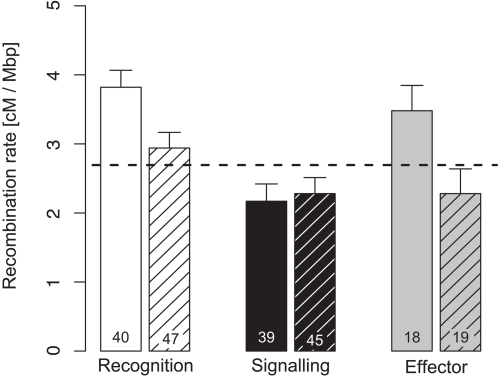
Average local recombination rates (± S.E.) of immune genes in the D. melanogaster genome.Immune genes were grouped according to their function during the immune response and whether they were contained in a cluster (open columns) or not (hashed columns). The dashed horizontal line gives the average genomic background recombination rate. The numbers inside each bar represent the number of immune genes found in the respective group. Details on statistical differences can be found in Table 2.